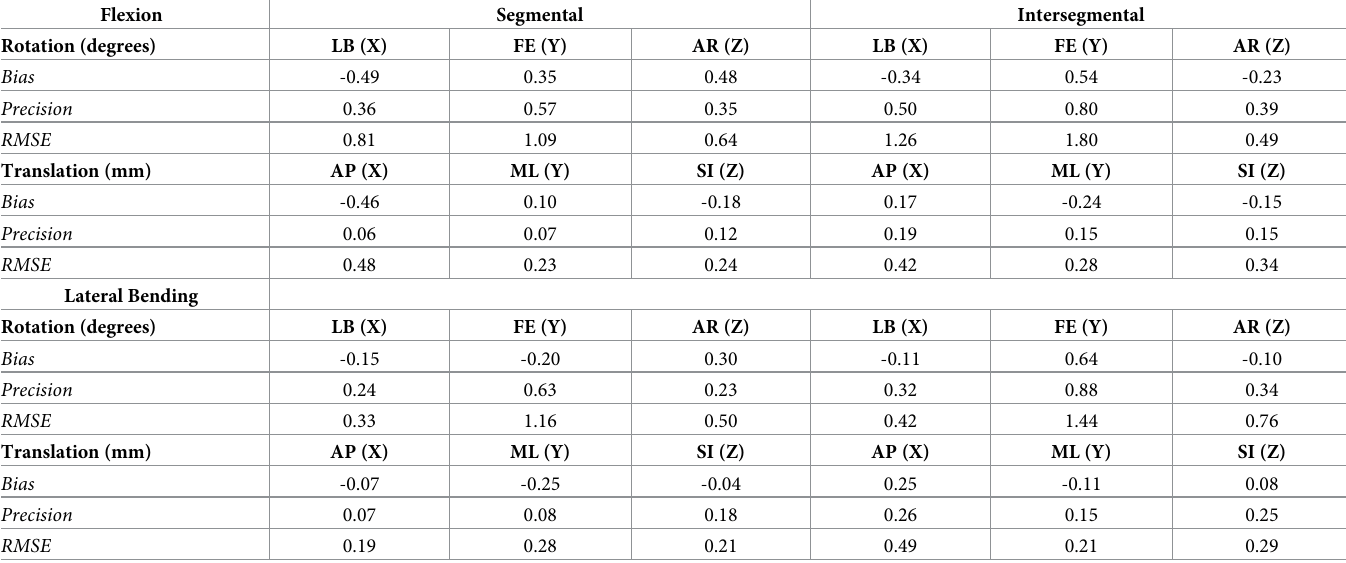
Table 1. Cervical spine summary of